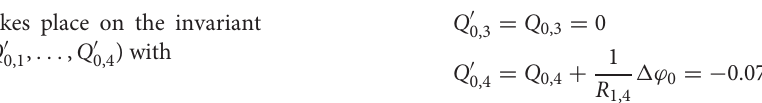
As represented in Figure 4 , the new link makes the fourth MOC to synchronize with the others, and then